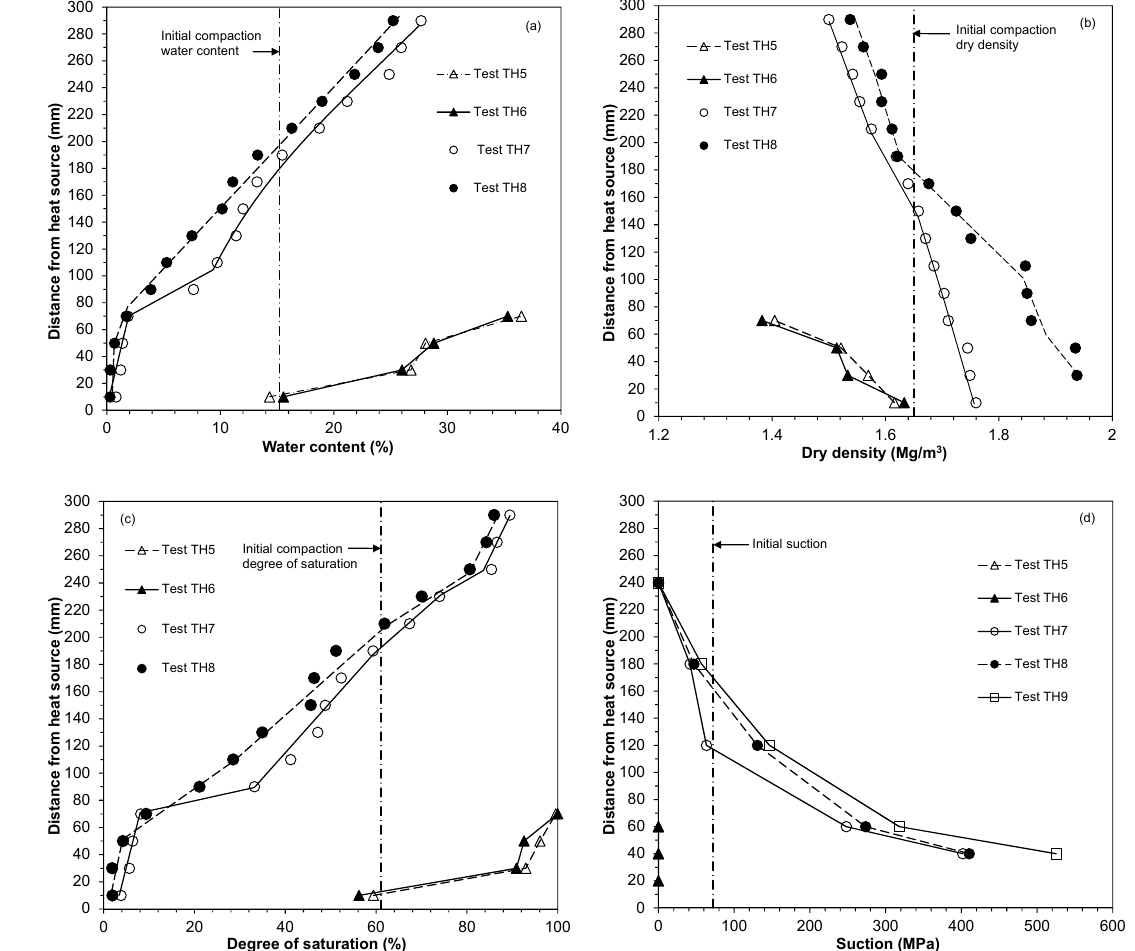
Figure 16. Profiles of: ( a ) water content; ( b ) dry density; ( c ) degree of saturation; ( d ) suction, for non-isothermal hydraulic tests at 85 °C and 150 °C.